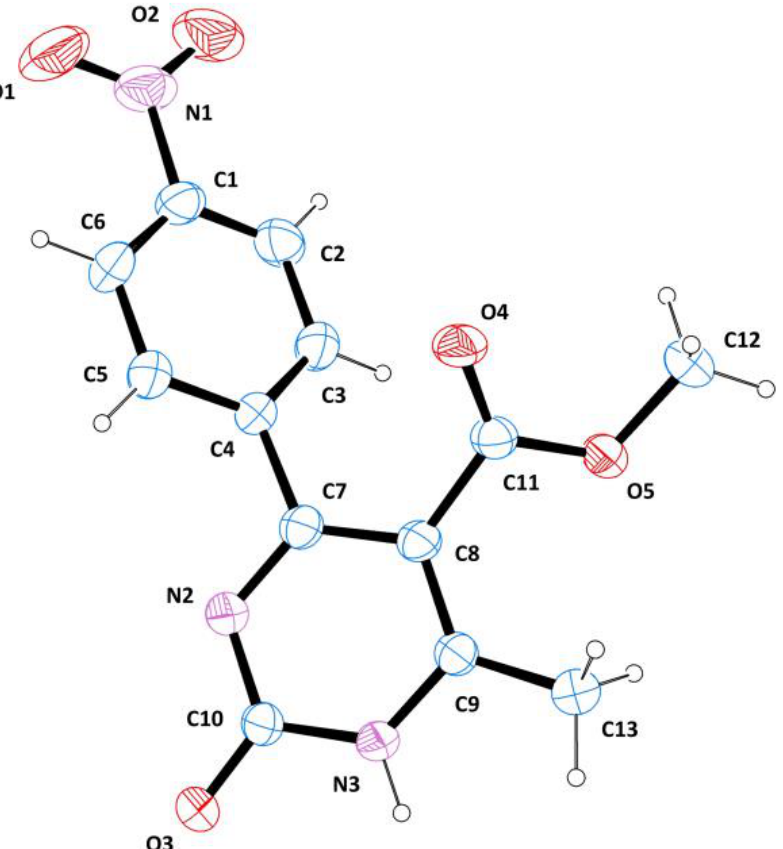
Figure 3. ORTEP diagram of 2 , with the arbitrary atom-numbering scheme. Thermal ellipsoids are drawn at the 40% probability level.